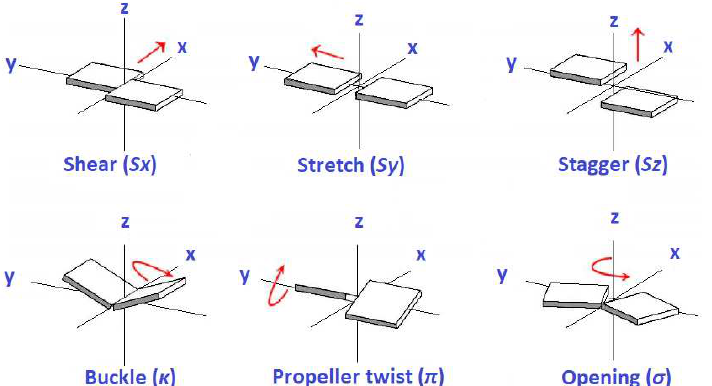
Figure 1. Definitions of translation parameters ( top row ) and rotation parameters ( bottom row ) involving two bases of a base